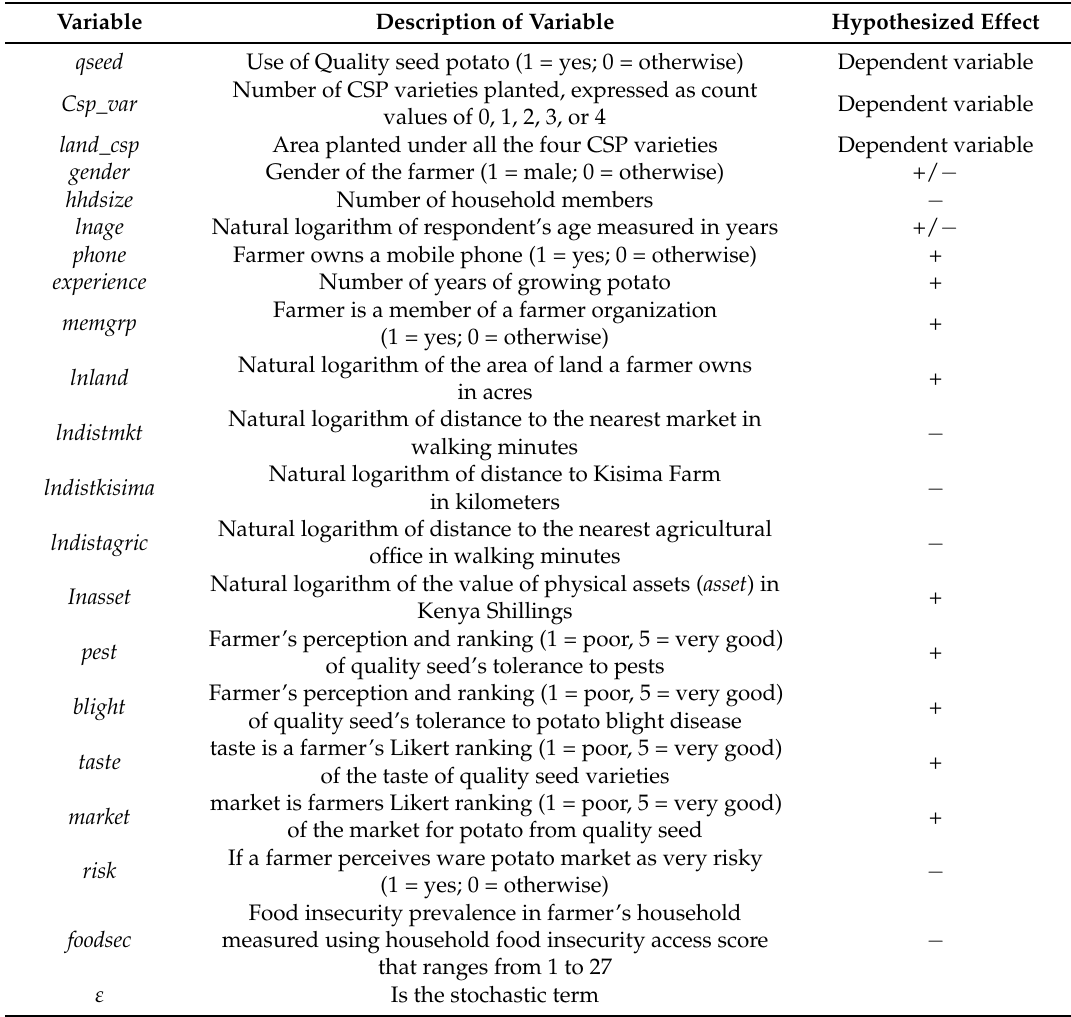
Table 1. Variables used in the models and their hypothesized effects on the use of certified seed potato. Variable Description of